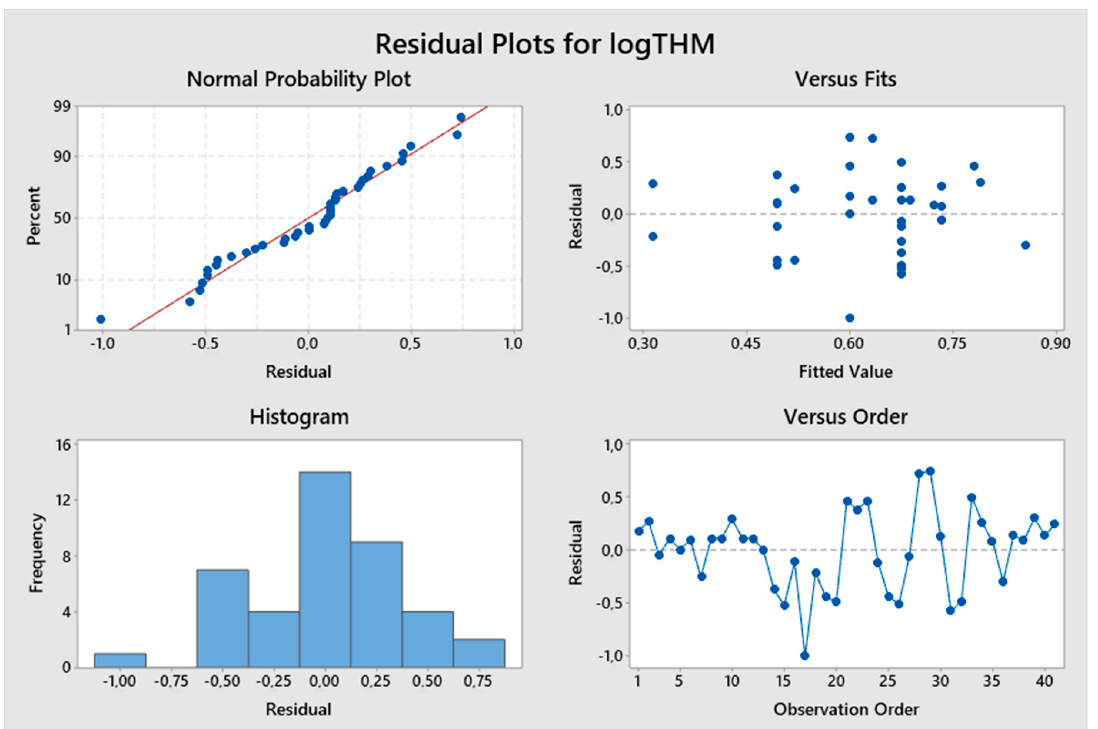
Figure 2. Residual plots for model (3).